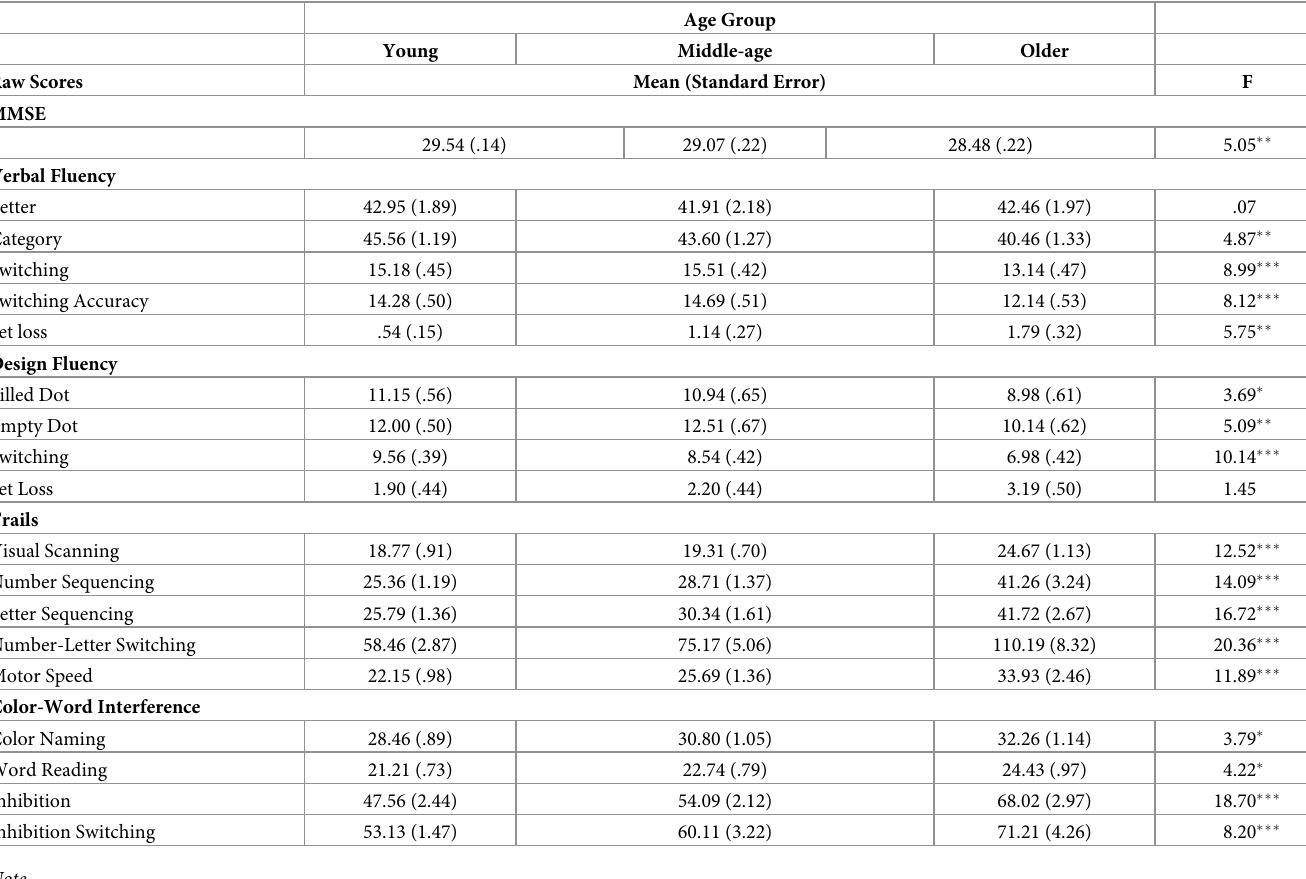
Table 3. Raw score means and standard error of cognitive performance for the main effect of age